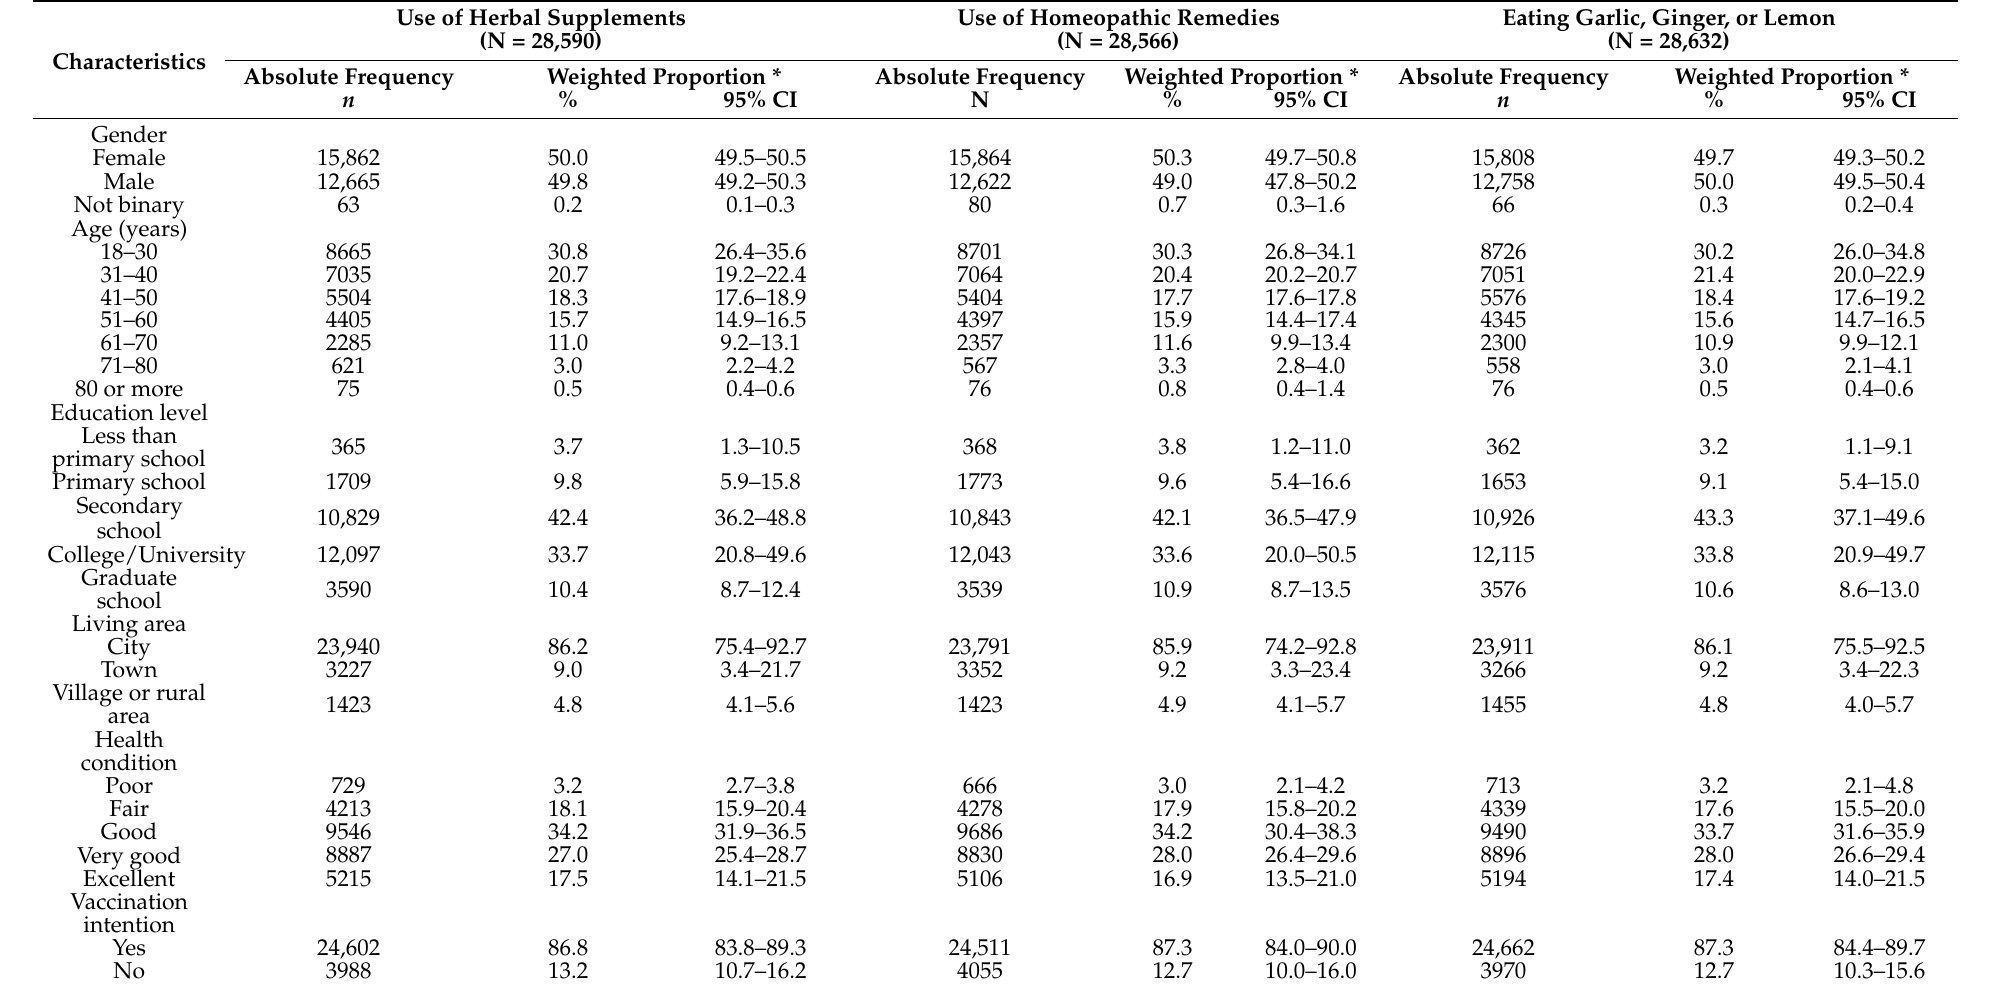
Table 1. General characteristics of the study sample: Use of herbal supplements ( n = 28,590; N = 404,219), use of homeopathic remedies ( n = 28,566; N = 409,920), the consumption of garlic, ginger, and lemon ( n = 28,632; N =